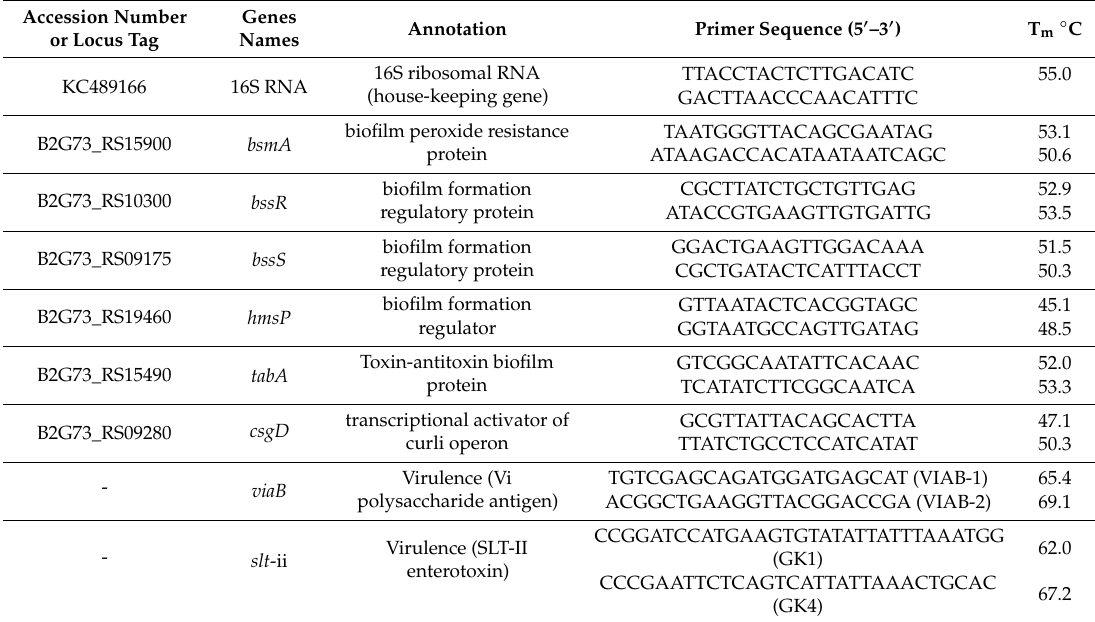
Table 4. Gene annotations and primer sequences of the biofilm-related and virulence genes in A. hydrophila and C. freundii.